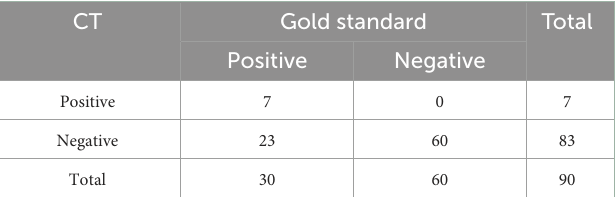
TABLE 2 Positive distribution of CT and gold standard examination in 90